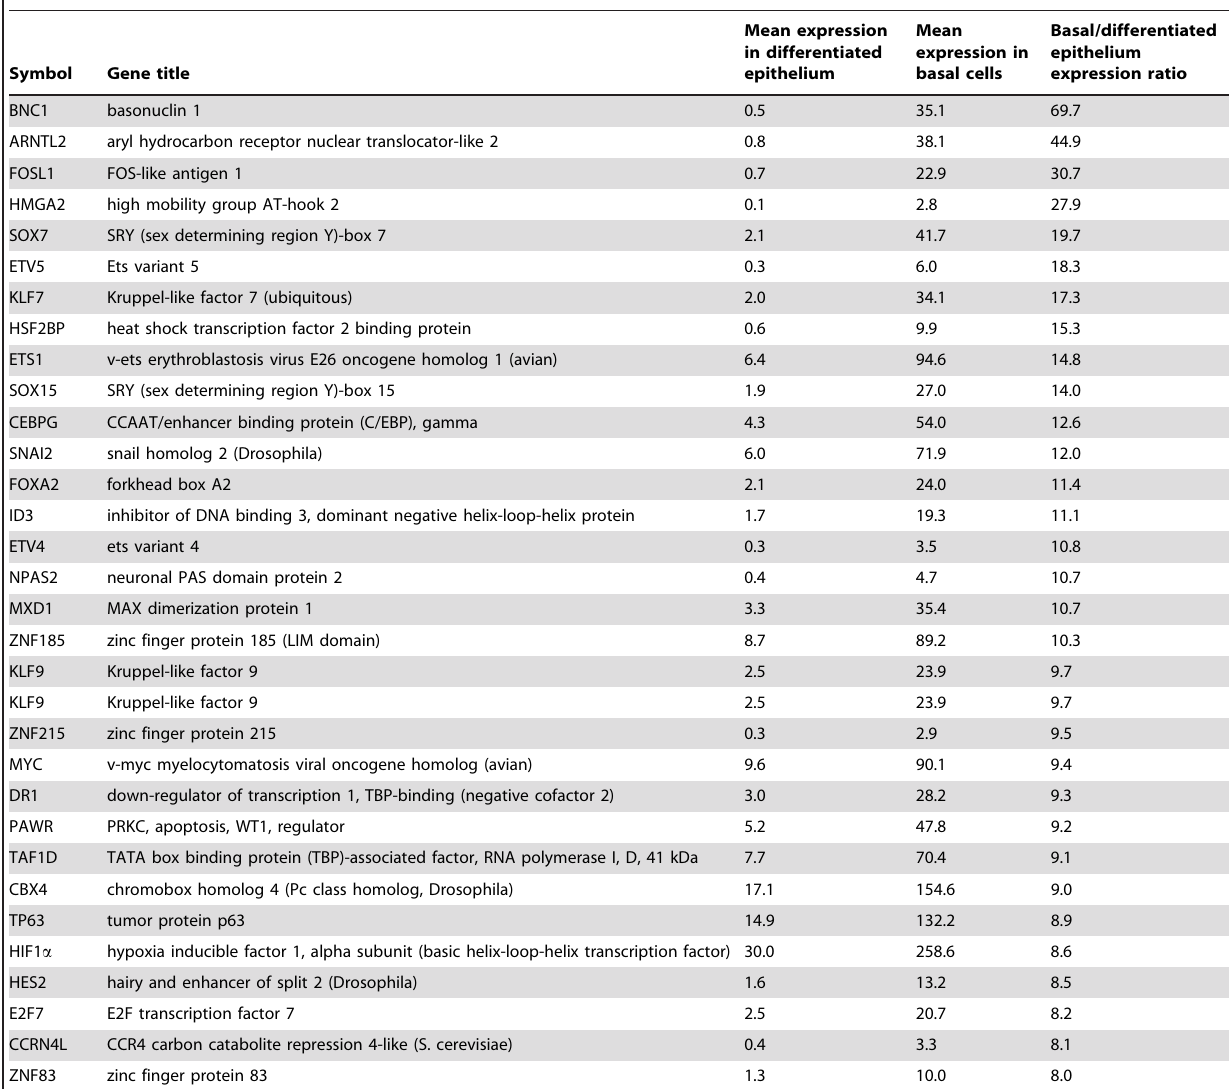
1 Genes identified by GATHER KEGG categories (Table 2, Table S3), Gene Ontology categories (Table 3, Table S5) and/or Canonical Pathways (Table 4, Table S6). The top genes based on expression ratio are shown.